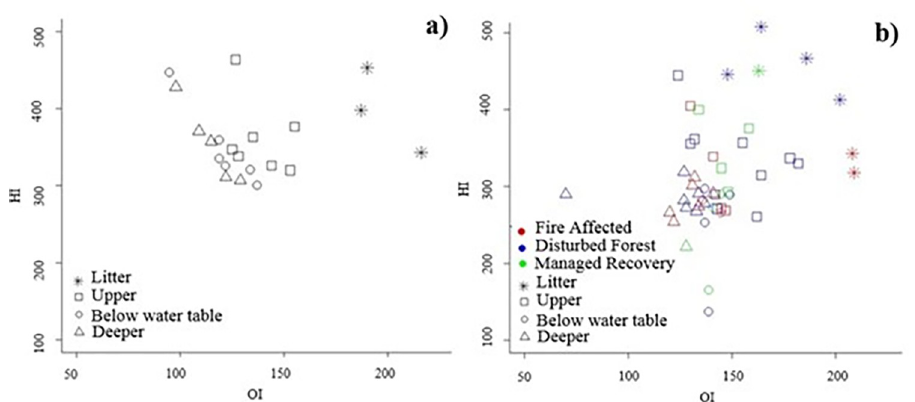
Fig 4. Van Krevelen pseudo diagrams. (a) Central Forest; (b) disturbed